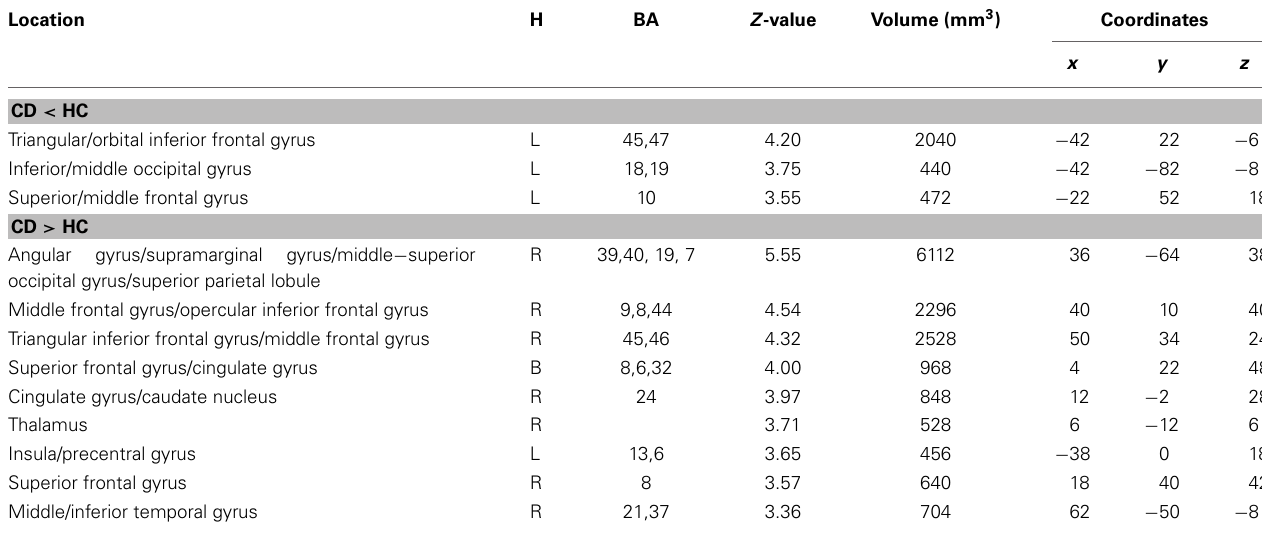
Table 3 | Comparisons between congenitally deaf individuals (CD) and hearing controls (HC) for the meaning task.